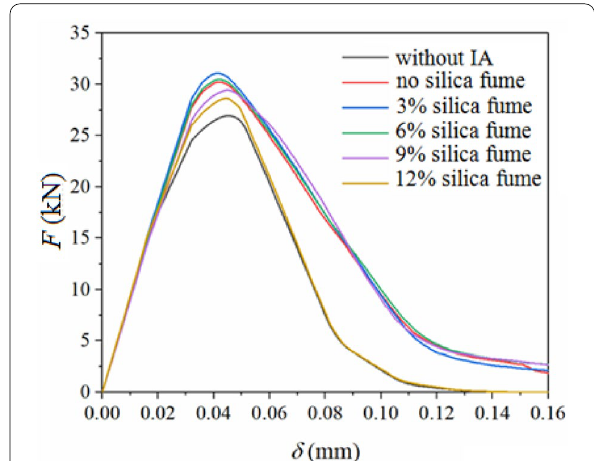
Fig. 20 Load–displacement curves for different silica fume contents in interfacial agent (IA)